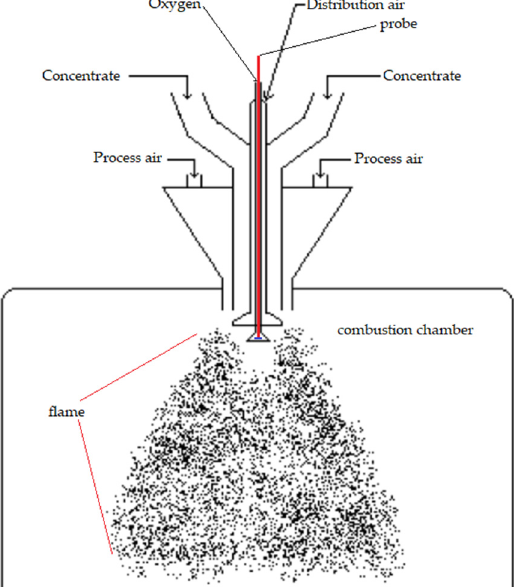
Figure 10. Position of the probe in a industrial flash smelting burner.